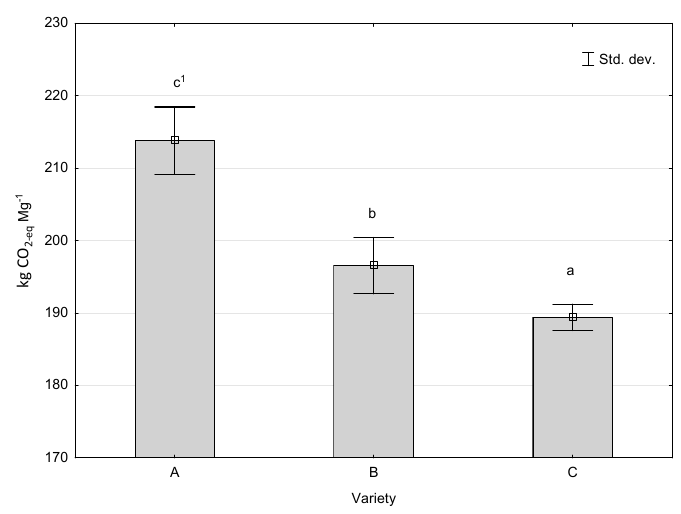
Figure 5. Average GHG emissions per one Mg of fresh fruit yield with dependence to training system (A, B, C). 1 Means with different letters are significantly different, according to Tukey test ( p ≤ 0.05). Table 6. Energy consumption and greenhouse gas (GHG) emissions associated with agricultural treatments, fertilizers and pesticides.